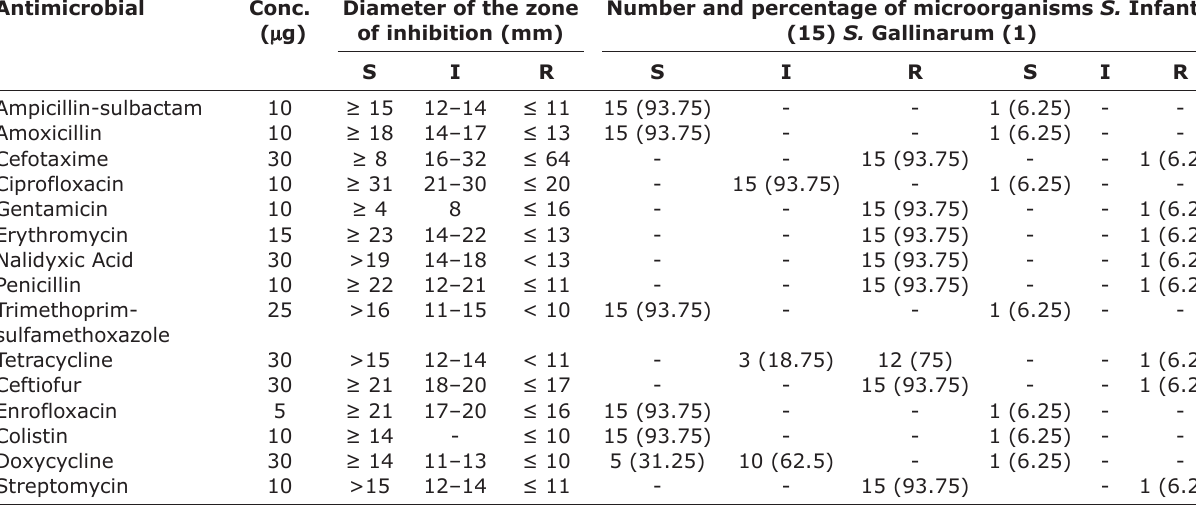
Table-2: Results of the phenotypic resistance of the isolates of S . Infantis and S . Gallinarum obtained from the litter in poultry farms. Antimicrobial Conc. Diameter of the zone ( μ g) of inhibition